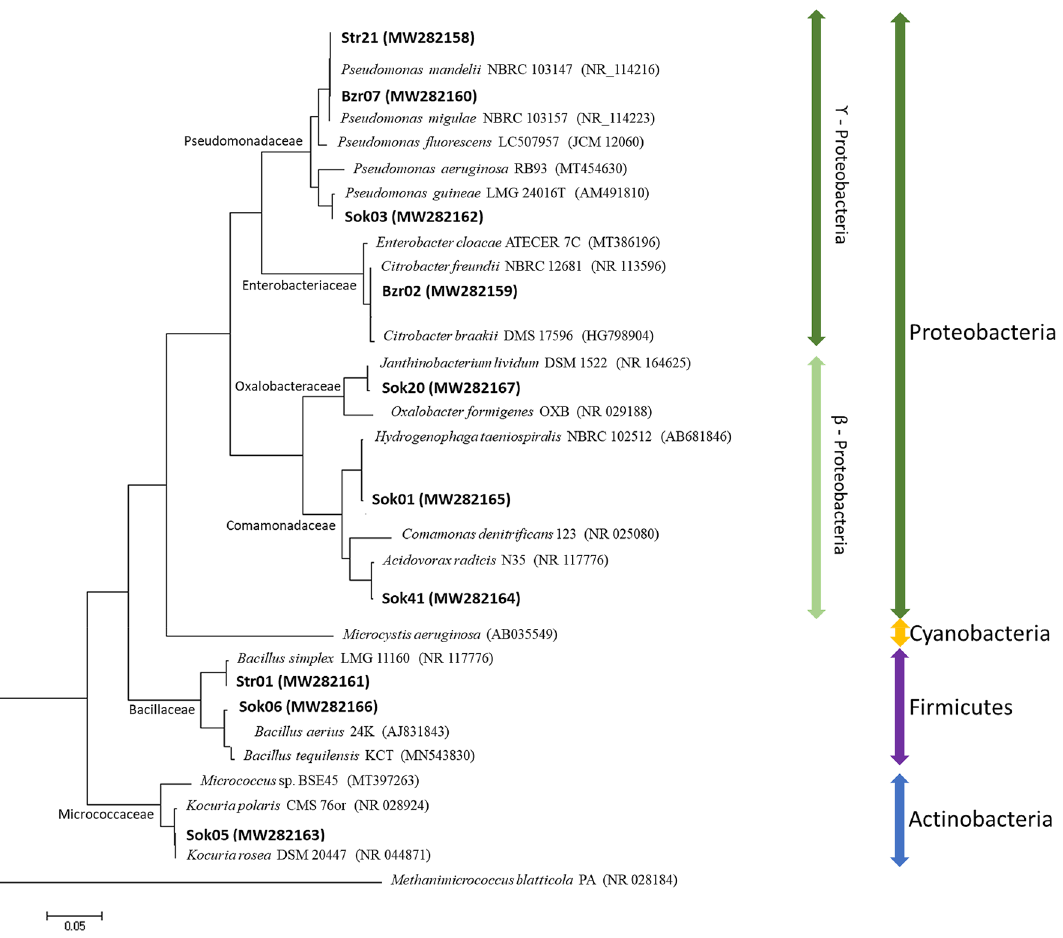
Figure 1. Neighbour-joining phylogenetic tree construction for the nitrogen transforming bacteria isolated in SSBSs. The tree was constructed using the 16S rRNA sequences obtained from GenBank (accession number inside the brackets). The bar under the graph represents the nucleotide substitutions per position. The sequence of Microcystis aeruginosa was used as an outgroup to cluster the representative strains in the phylum Proteobacteria, and the sequence of Methanimicrococcus blatticola PA (Archaea) as an outgroup to cluster the different bacteria